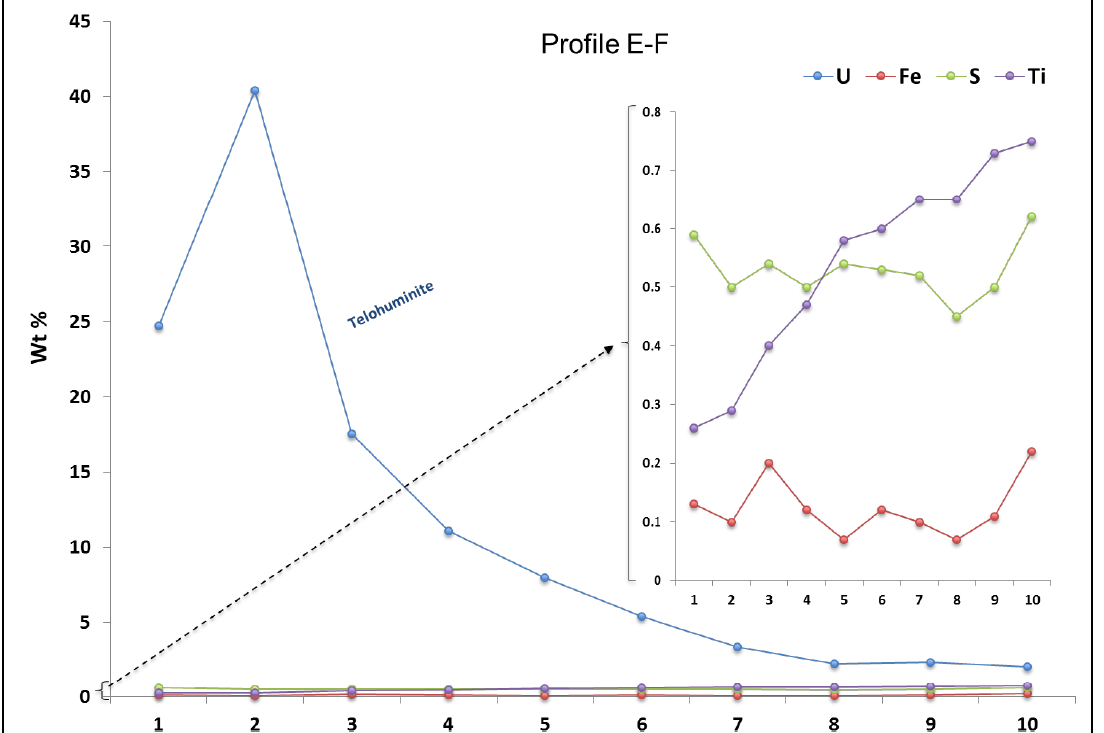
Figure 11. Profile E-F was performed on a telohuminite particle with uranium expressed as UO 2 at the rims. U concentration starts at 25 wt % at the rim. As shown in Figure 10F, the first point was measured on a part of the particle where UO 2 is not expressed as uraninite. The next spot was measured on a part where U is expressed as uraninite, hence the concentration is raised to 41 wt %. Afterwards the U concentrations decrease proportionally as a function of increasing distance from the particle rim. The Fe and S concentrations are at 0.1 and 0.5 wt %, respectively (with a detection limit of 0.1 wt %), as shown in the upscaled part of the graph. Titanium concentration increases from the rim towards the interior of the particle, from 0.26 to 0.75 wt %.